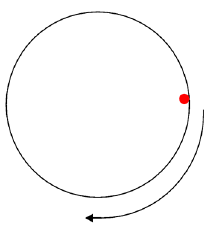
Figure 4. Laser drilling movement.